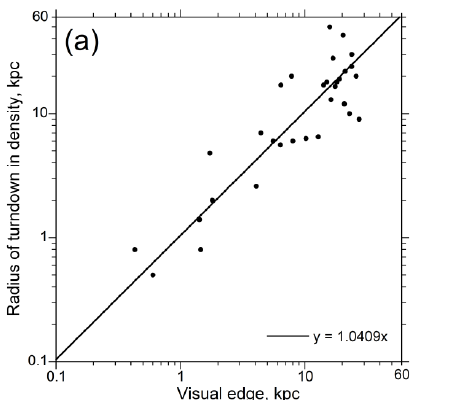
Figure 9. Various measures for the density of galaxies compared to their size, set to the visual edge at 25 B-magnitude arcsec − 2 . ( a ) Spiral and similar galaxies. M82 is included since near-IR images [23] suggest it is a spiral. Highest and lowest densities are depicted, but these values depend somewhat on smallest and largest radii explored in each RC study. For reference, we include ρ measured at r = 0.1 kpc and ρ measured at the visual edge. The polar ring galaxy has lower ρ than ordinary spirals of similar size. ( b ) Morphologies other than spiral. Fits to ellipticals (lines) roughly also describe the lenticular and spheroidal classes and are similar to fits for spirals.